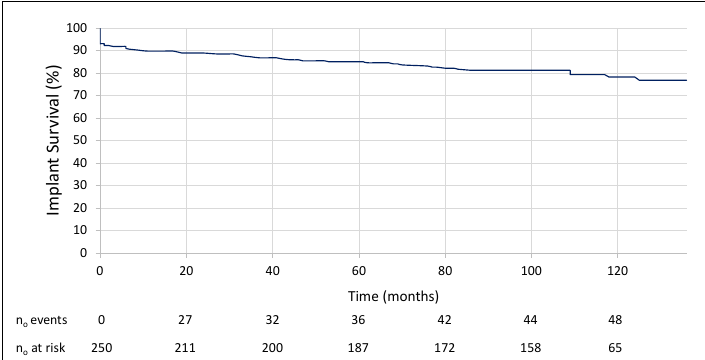
Figure 5. Graft Survival curve (Kaplan Meier method model).